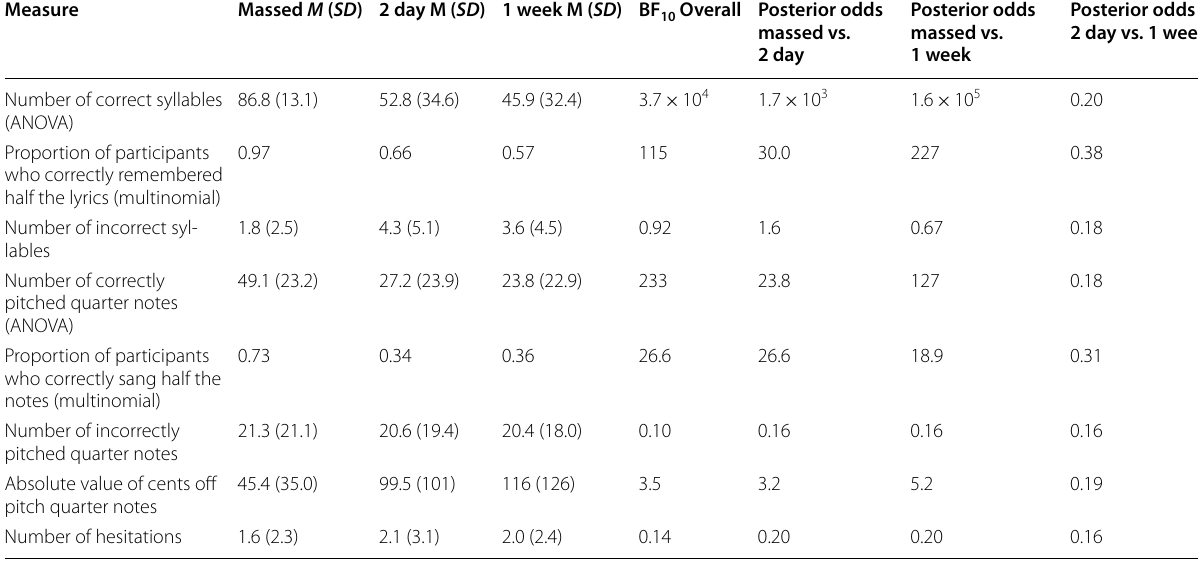
Table 2 Measures of forgetting at test 2.2